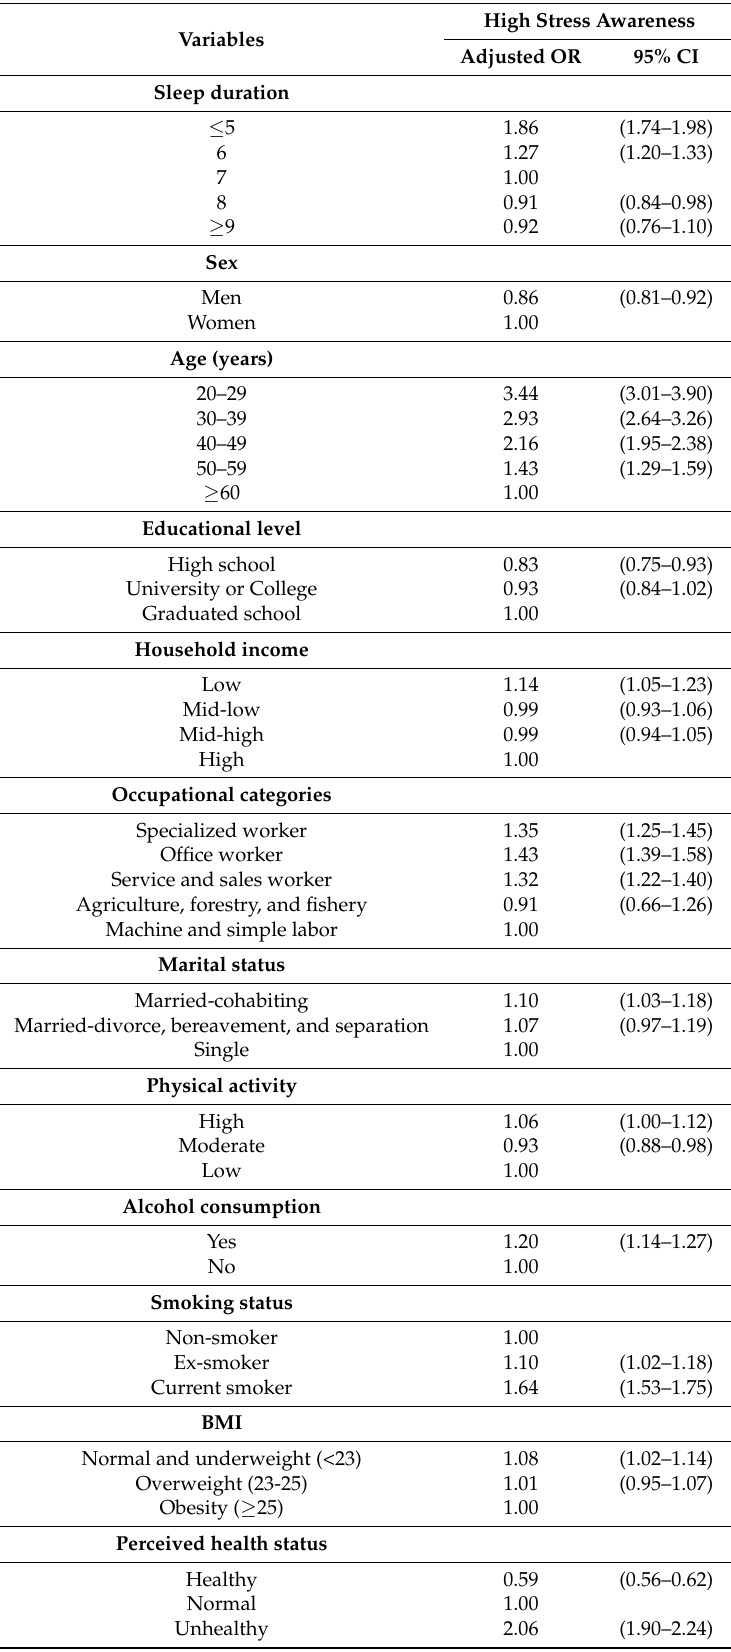
Table 2. Results for high-stress awareness according to